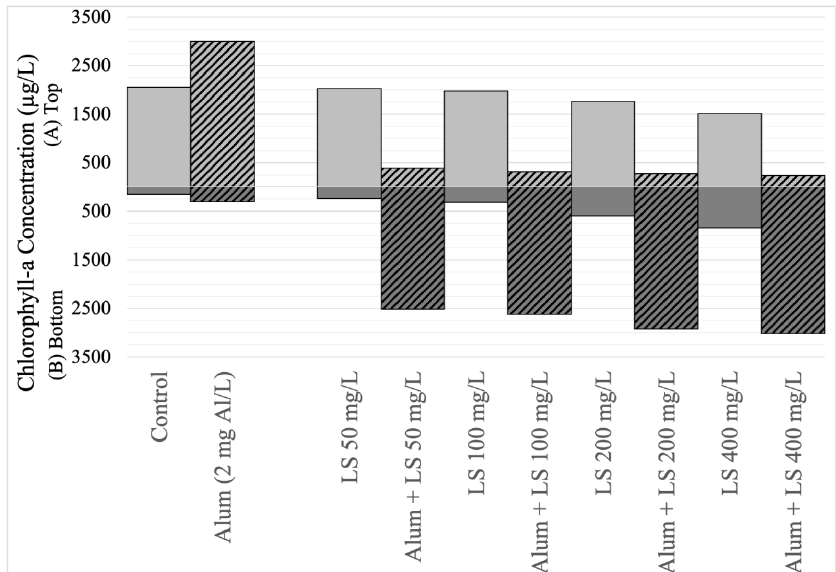
Figure 6. Mean ( n = 3) chlorophyll-a concentrations (in micrograms per liter) in the top 40 mL (light gray bars, positive scale) and bottom 40 mL (dark gray bars, negative scale) sampled from 250-mL cyanobacteria suspensions (mean initial chlorophyll-a concentration = 485 µg/L) and left stagnant for 1h following treatment. Treatment indicated in x -axis label as control (no treatment), Alum (application of 2 mg Al/L of alum), LS (dose of local soil with concentration noted), and Alum + LS (2 mg Al/L of alum combined with local soil at concentration noted). Each dose of LS combined with alum (indicated using diagonal stripe pattern) was compared against equivalent LS dose without alum (indicated using solid pattern).